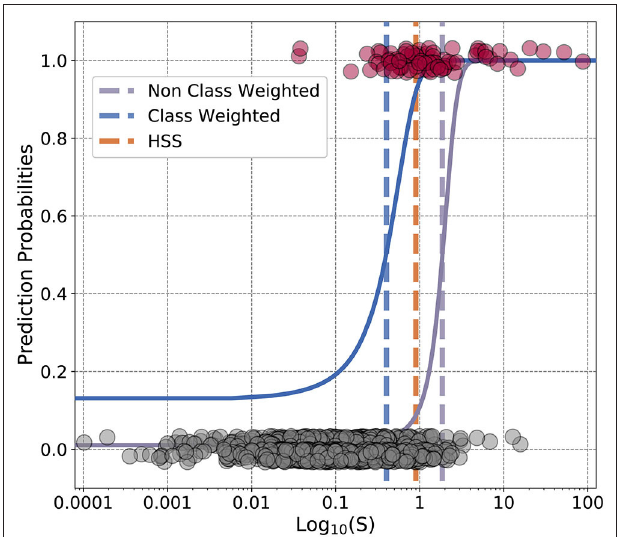
FIGURE 6 | Finalized logistic regression against test dataset. The gray dots represent the test dataset values of non-events, and the pink of events. The scatter in the dots around 0 and 1 are for aesthetic reasons and do not represent offset values. This figure contains logistic regressions performed on the physics-based parameter from Azari et al. (2018). The blue curve represents a class-weighted model and the purple without class weights. Similarly the dashed lines for blue and purple represent the finalized cut-off points for the class-weighted and un-weighted models. The orange dashed line represents the HSS optimization used within Azari et al. (2018). The x-axis is in logarithmic scale to demonstrate the range of the values, S itself does span both negative and positive values. From being presented in logarithmic space this gives the false illusion that the blue curve does not approach zero.